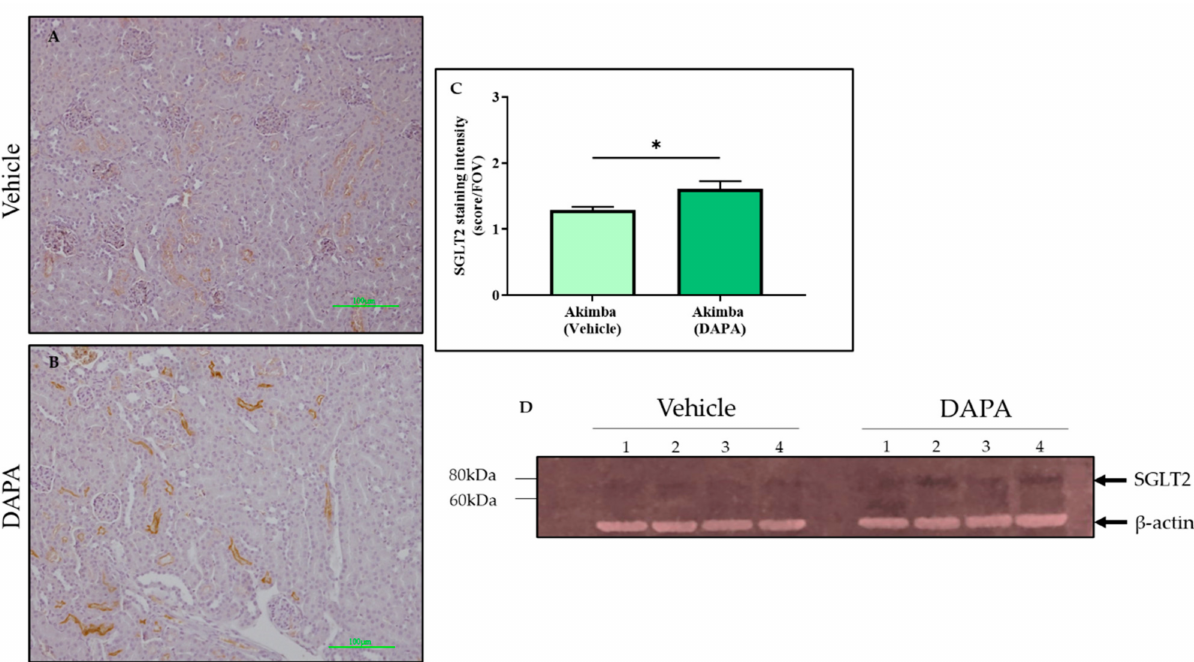
Figure 6. DAPA increases SGLT2 protein expression in the kidneys of diabetic Akimba mice. Repre- sentative images of SGLT2-stained kidney tissues from diabetic Akimba mice treated with Vehicle ( A ) and diabetic Akimba mice treated with DAPA ( B ), SGLT2 quantification ( C ) and immunoblots for SGLT2 and b-actin ( D ). Scale bar = 100 µ m; n = 4 mice/group; using student’s t -test * p ≤ 0.05; DAPA: Dapagliflozin.